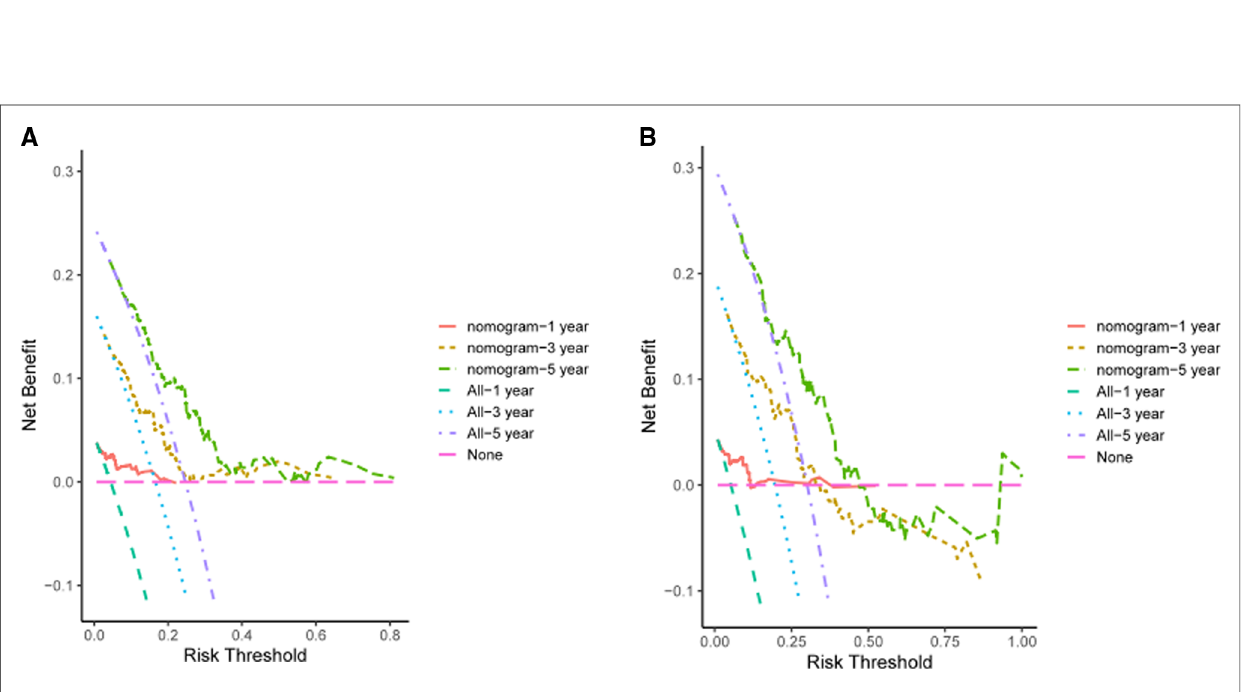
FIGURE 7 DCA of the LAR-nomogram for 1-year, 3-year and 5-year survival prediction in the training cohort ( A ) and validation cohort ( B